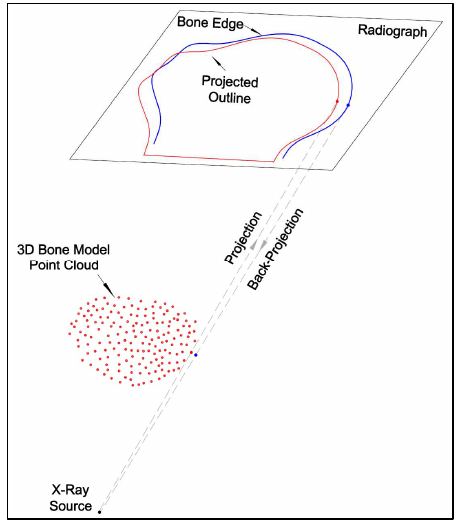
Figure 6. Illustration of the projection of the outline points and the back projection of the matching edge points.